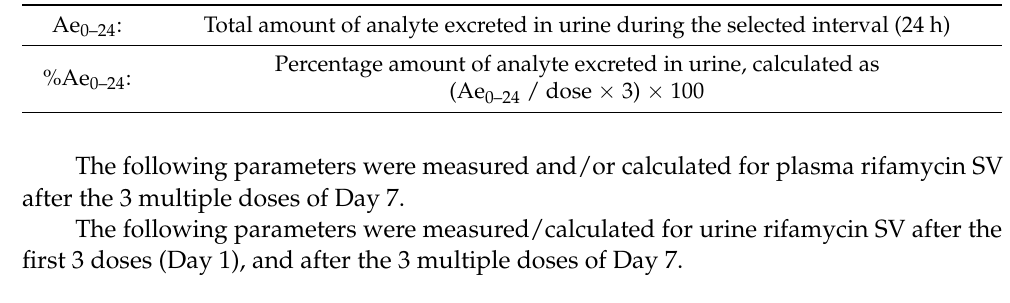
Table 3. Pharmacokinetic parameters planned to be measured and/or calculated for urine rifamycin SV after single and multiple doses.